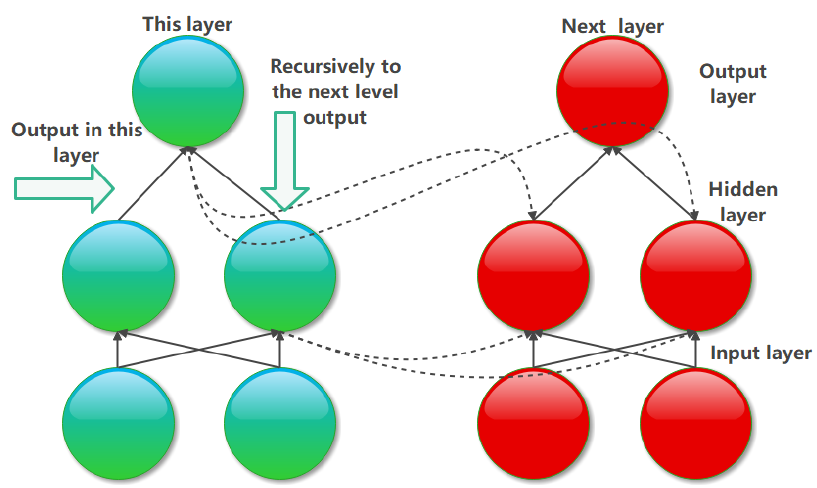
Figure 13. RNN algorithm model diagram output of the algorithm.